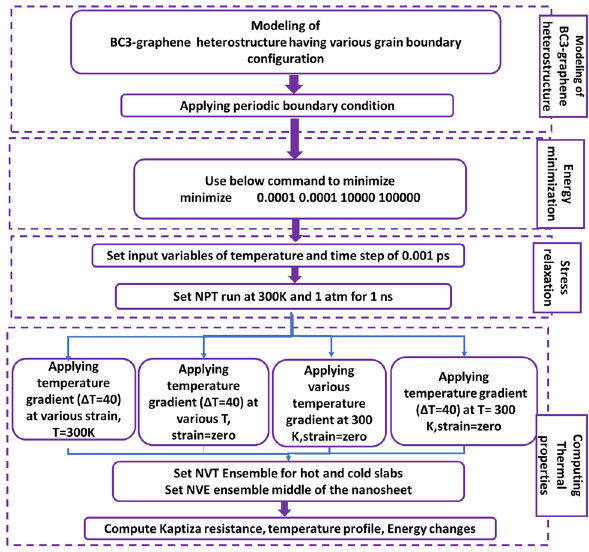
Figure 1. Flowchart of the overall simulation stages, including modeling, energy minimization, stress relaxation and calculation of thermal